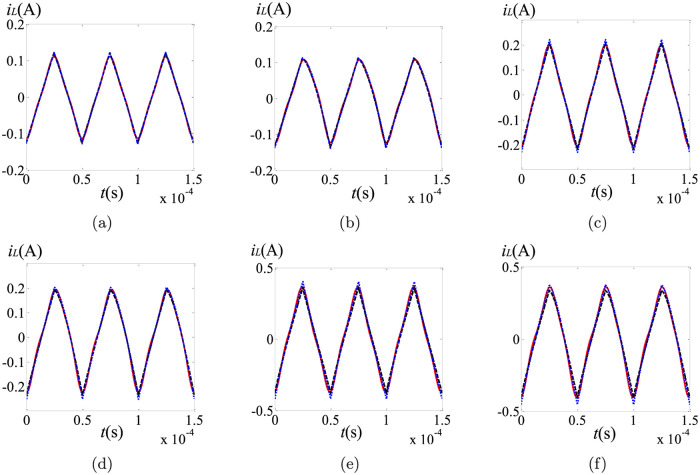
Comparison of the steady state ripples in iL under different fractional orders: (a) (α, β, γ) = (1, 1, 0.95); (b) (α, β, γ) = (1, 0.8, 0.95); (c) (α, β, γ) = (0.95, 1, 0.95); (d) (α, β, γ) = (0.95, 0.8, 0.95); (e) (α, β, γ) = (0.9, 1, 0.95); (f) (α, β, γ) = (0.9, 0.8, 0.95).